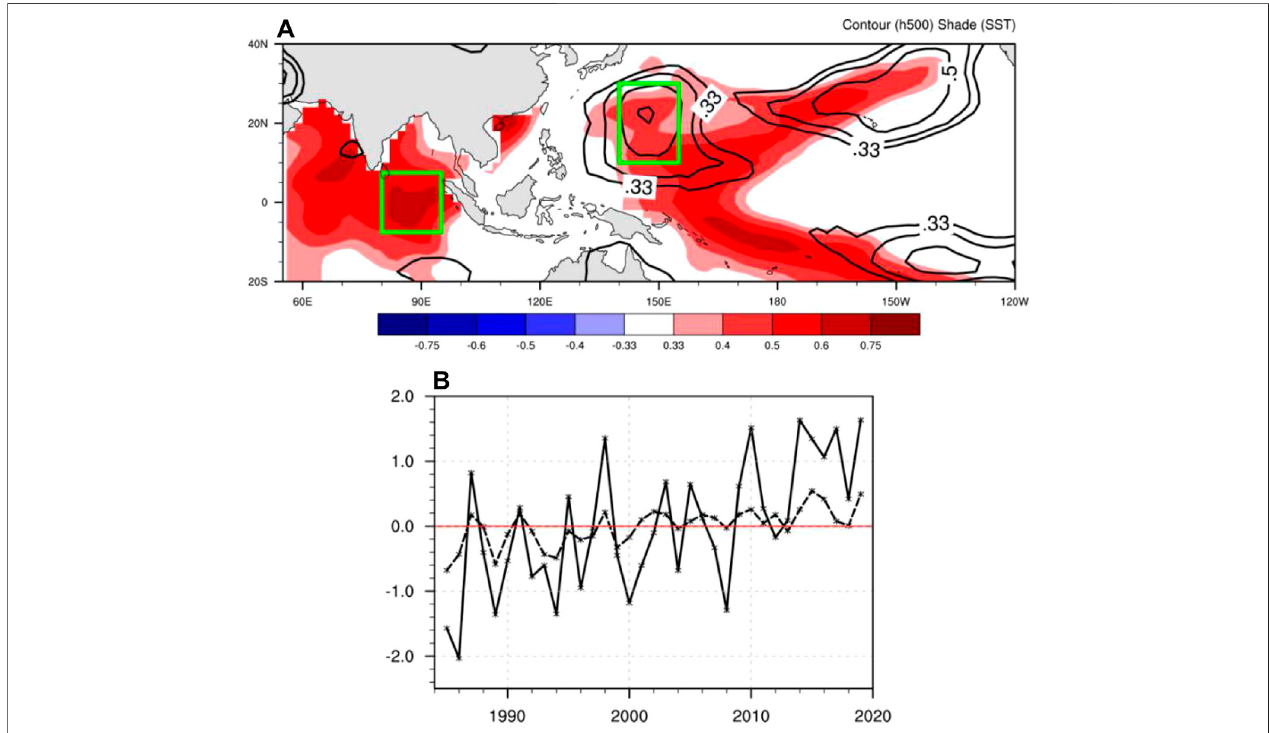
FIGURE9|(A) Correlationcoef fi cientsbetween500-hPaheight(contours), SSTanomaly(shade)andthepredictionskillsoftheWNPSHintensityin Figure8 ,only show the values that pass the 95% con fi dence t -test. (B) The standardized domain-averaged indices of the SST anomaly (dashed line) in the tropical Indian Ocean and 500-hPa height anomaly (solid line) in the western North Paci fi c, where the two domains are de fi ned by the boxes in (a).